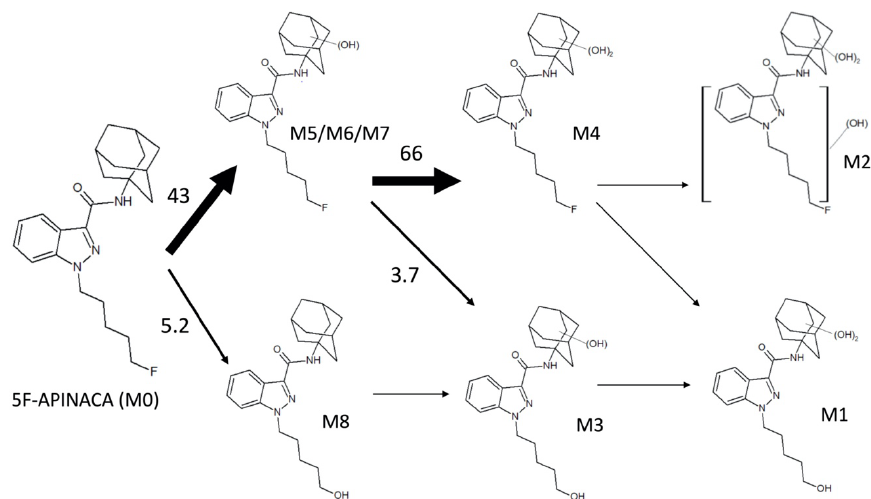
Figure 7. 5F-APINACA metabolic flux through competing and intersecting pathways. We estimated 5F-APINACA metabolic flux through primary and secondary metabolic steps using catalytic e ffi ciencies (V max / K m , pmol / min / mg protein / µ M product) for intrinsic clearance (Cl int ) with data in Table 2 and biasing selection for higher a ffi nity activities due to typical exposures to low 5F-APINACA levels in abusers [12]. M3 originates from either M8 or M5 / M6 / M7; however, levels of the latter metabolites vastly exceeded those of M8, making the observed kinetics more likely due to conversion of M5 / M6 / M7 to M3 as shown. Downstream tertiary metabolites M1 and M2 were observed but lacked kinetics, and thus their relative significance was not measurable. Taken together, the magnitude of the values reflects the preference for 5F-APINACA to proceed through indicated metabolic